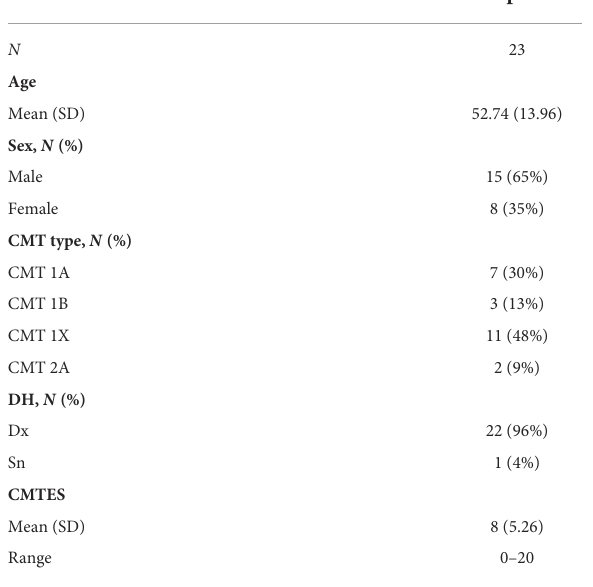
TABLE 1 Demographic and clinical characteristics of CMT patients.